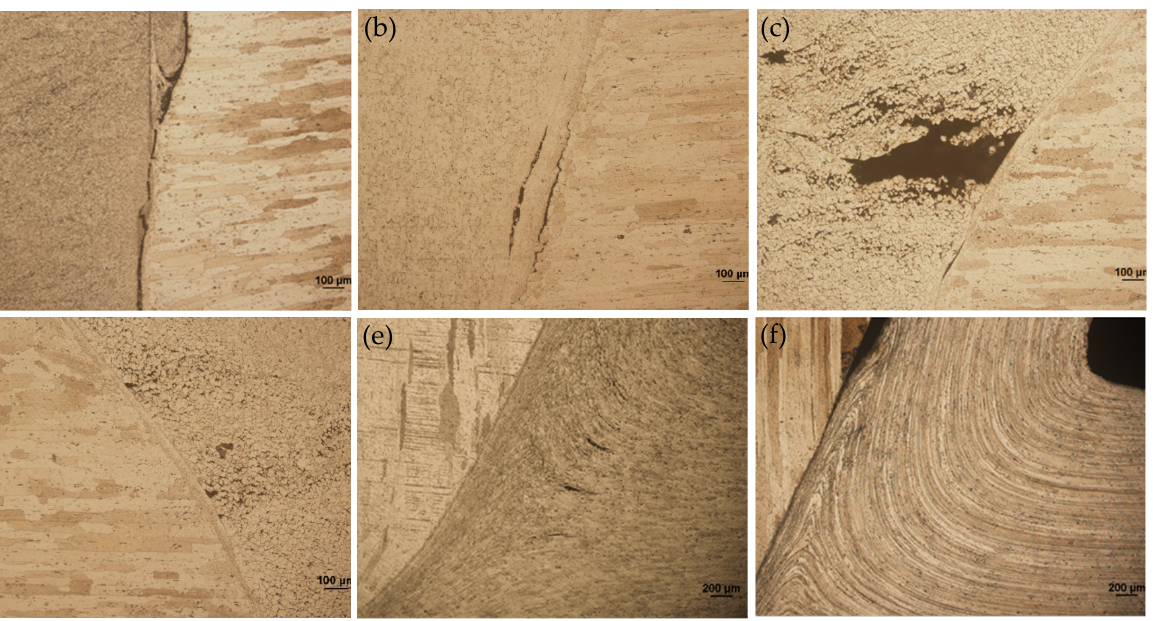
▲ unwelded defect, ★ weak ‐ bonding defect, ● hole ‐ type defect, ◆ tissue loose defect, ■ insuffi ‐ cient filling defect.